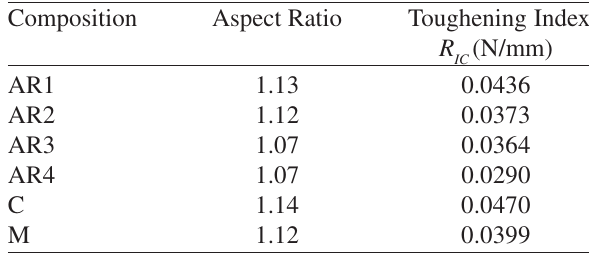
Table 1. Average values of and R in unfired specimens.